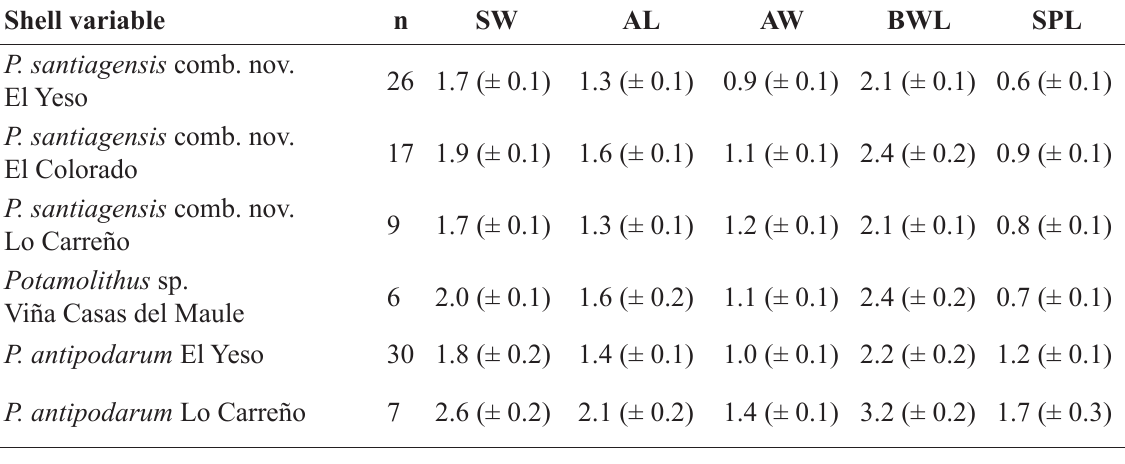
Table 1. Average shell dimensions (± standard deviation) of six linear variables used in the comparative